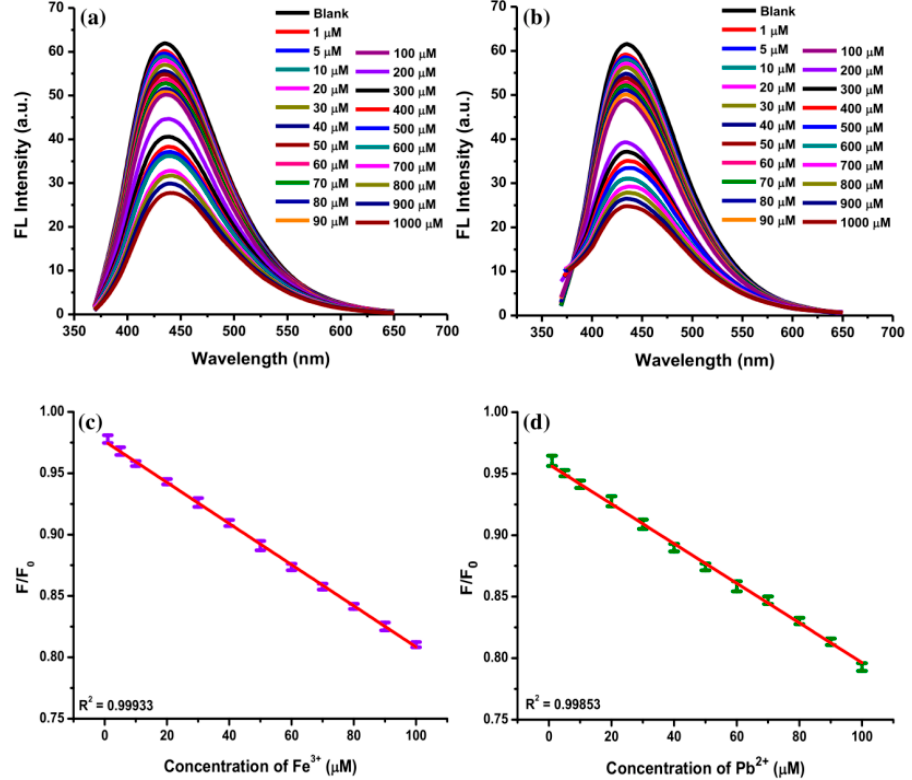
Figure 7. The FL emission spectra of VV-CDs excited at 360 nm at various concentrations (1 to 1000 µ M) of ( a ) Fe 3 + ions and ( b ) Pb 2 + ions. The linear correlation of F / F 0 values versus the concentration (1–100 µ M) of ( c ) Fe 3 + ions and ( d ) Pb 2 + ions.